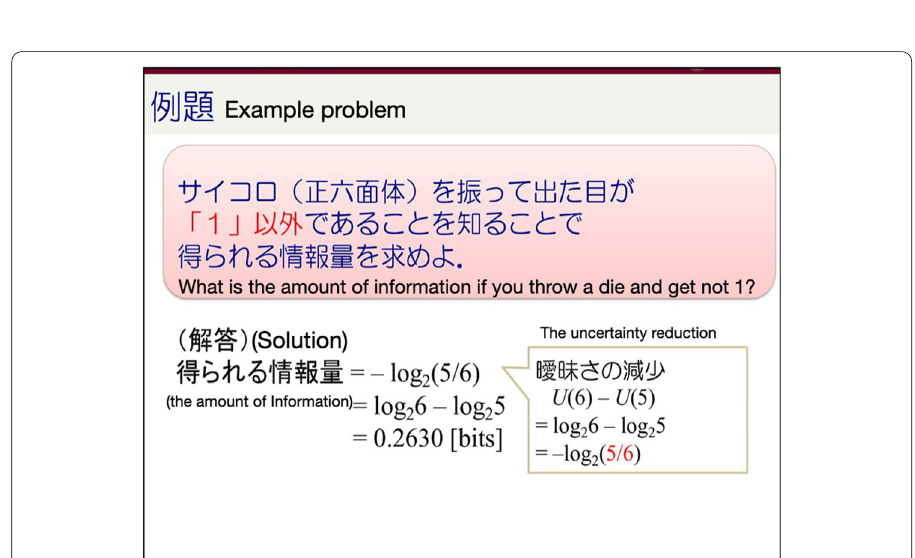
Fig. 14 An example of Type 2 page: Example problem and